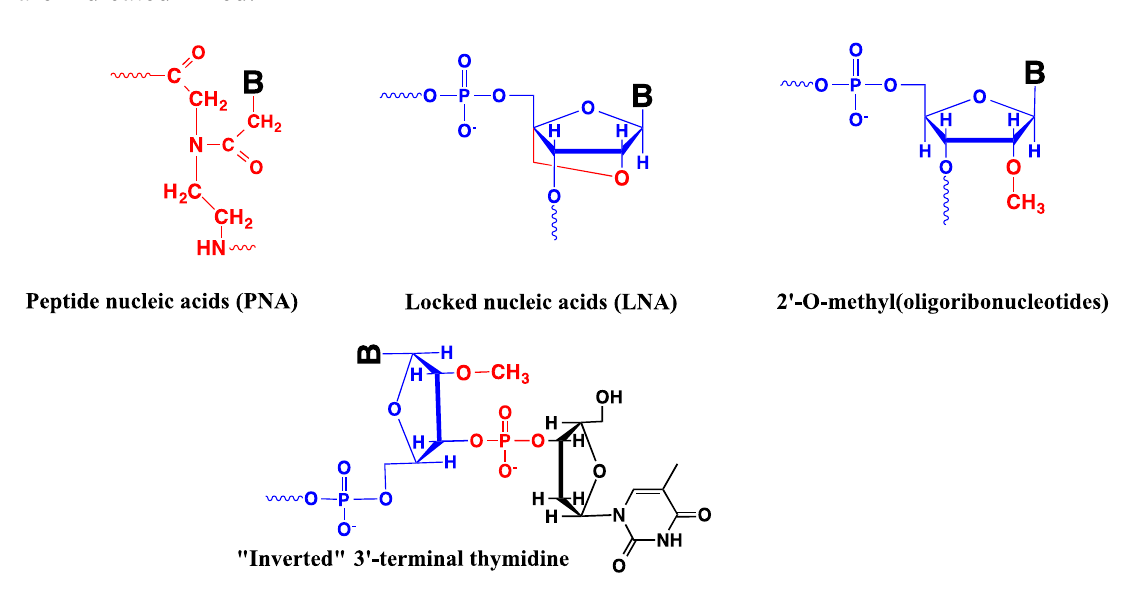
Figure 19. Modified oligonucleotides used for probe design. B—nucleobase. Modifications are indicated in